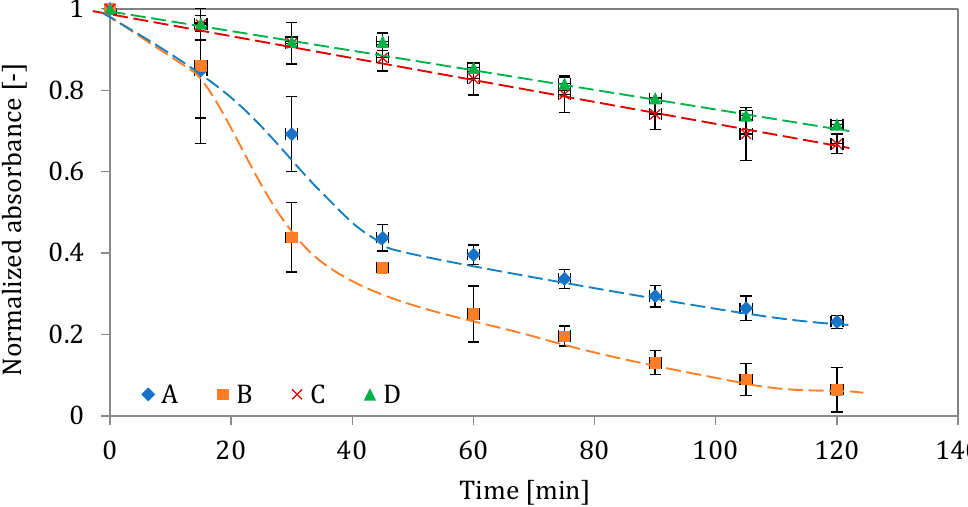
Figure 4. Stability of BUD suspensions A, B, C, and D, as illustrated by the relative change in the light absorbance. Error bars show the standard deviation ( n = 3). Lines are drawn to guide the eye. Table 3. Electrokinetic characteristics of the BUD formulations (SD = standard deviation, n = 3). Original samples were diluted due to a too-high electrolyte concentration.